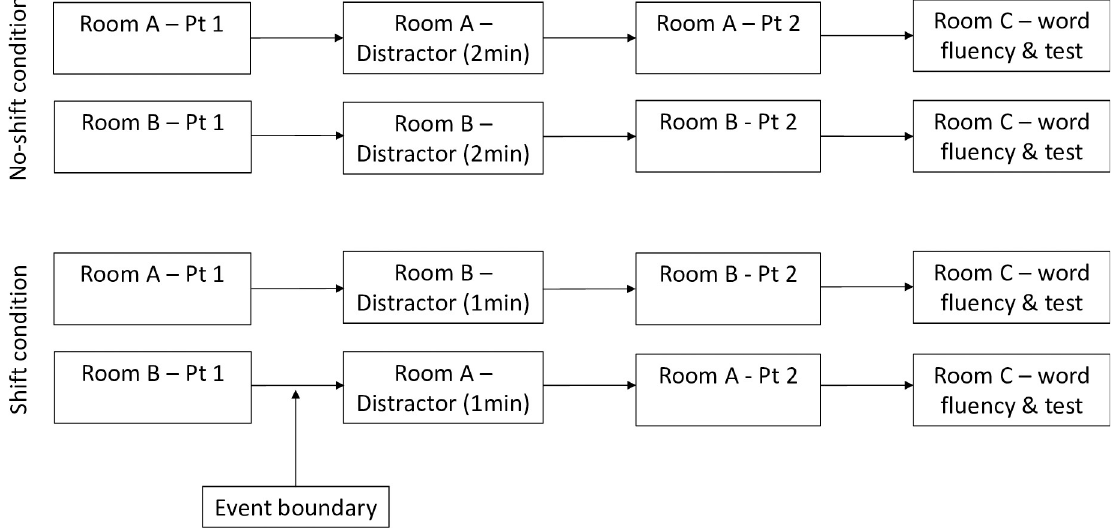
Fig 2. Schematic depiction of Experiment 1’s no-shift and shift conditions procedure. Note: Pt 1, part one of the event report; Pt 2, part two of the event report.